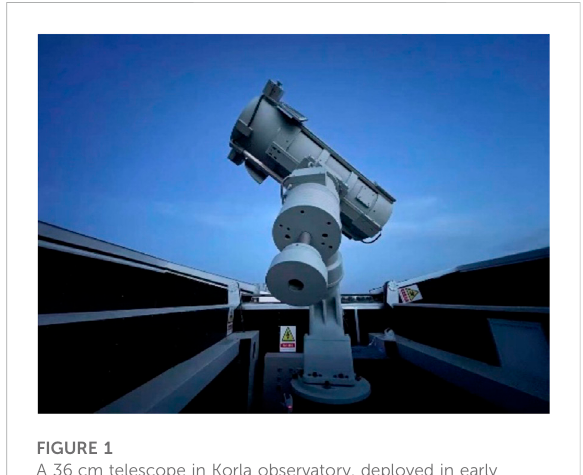
FIGURE 1 A 36 cm telescope in Korla observatory, deployed in early